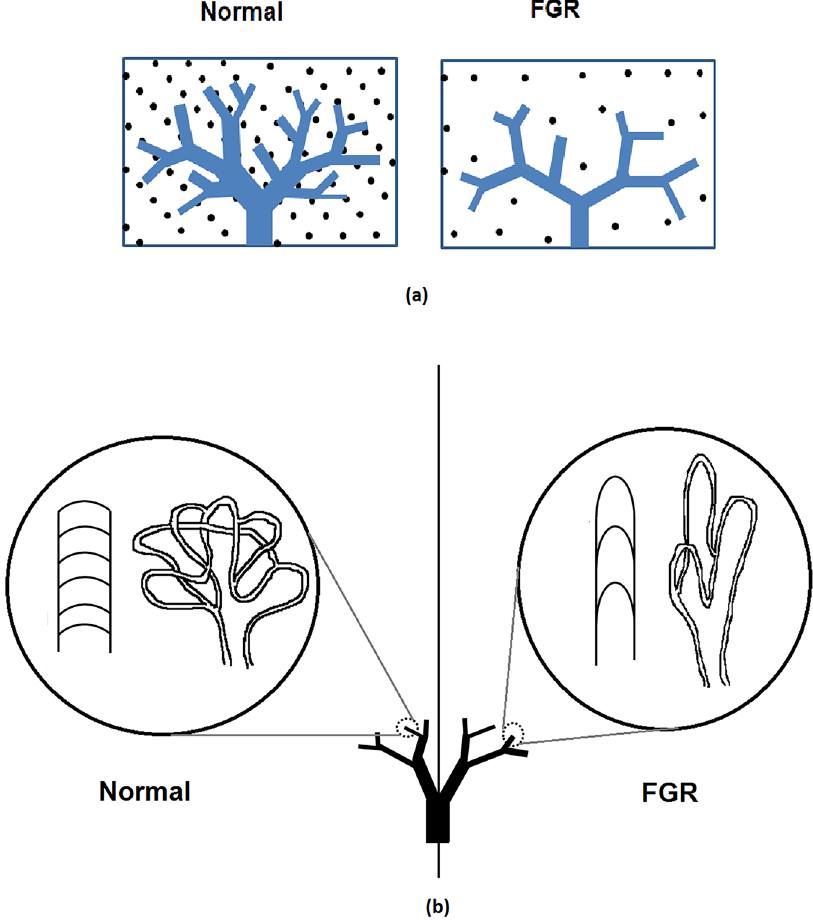
Figure 1. ( a ) A schematic diagram illustrating computational model generation for pre-capillary placental vascular branches. The placental volume is seeded with a fixed density of points, and tree structures are grown toward these points. Sparser seed points result in a sparser vascular tree. ( b ) A schematic diagram of capillary loops that reside distal to intermediate villi and are simplified in the model as a lumped structure. In normal placentae capillary branching is denser than that in FGR